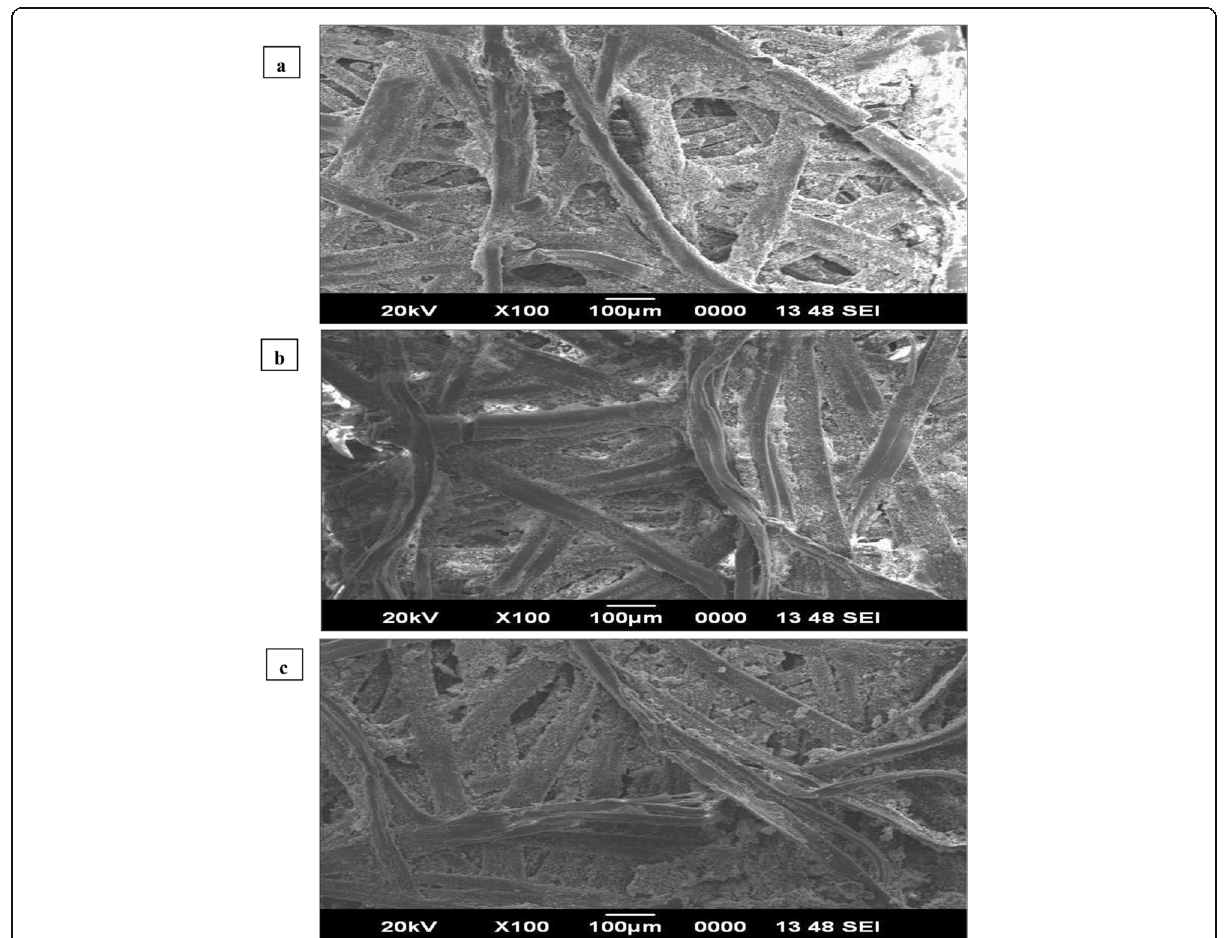
Fig. 16 SEM image of silk sheet showing surface morphology. Surface morphology of silk sheet after cocoon treatment with buffer ( a ), surface morphology of silk sheet after cocoon softening using cocoonase enzyme ( b ), and surface morphology of silk sheet after treatment with Na 2 CO 3 ( c